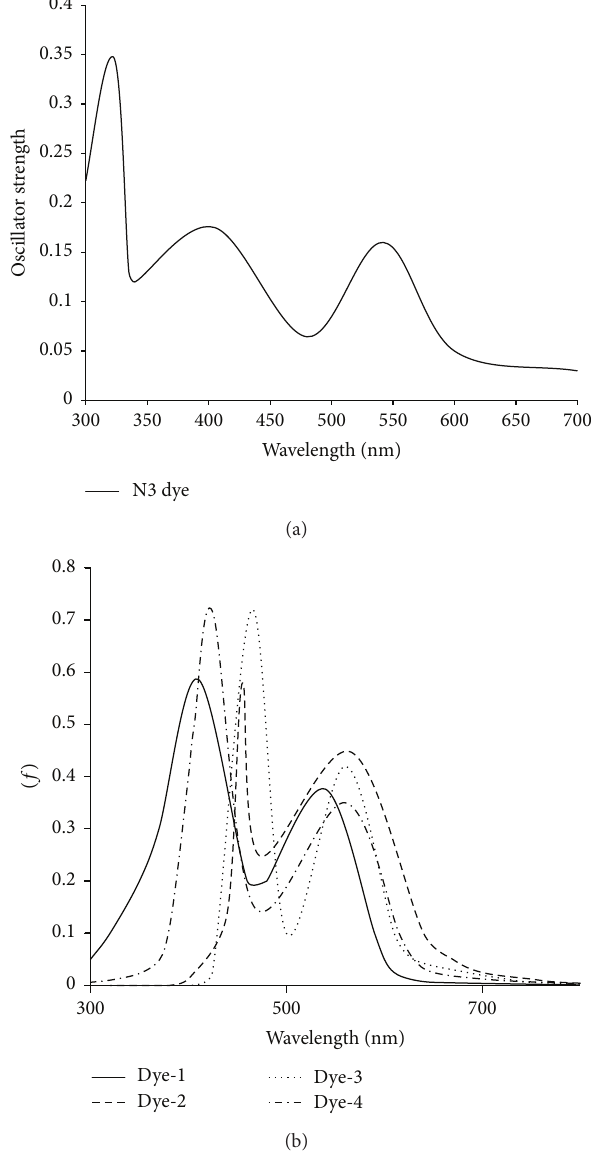
Figure 2: Simulated absorption spectra of (a) N3 and (b) systems